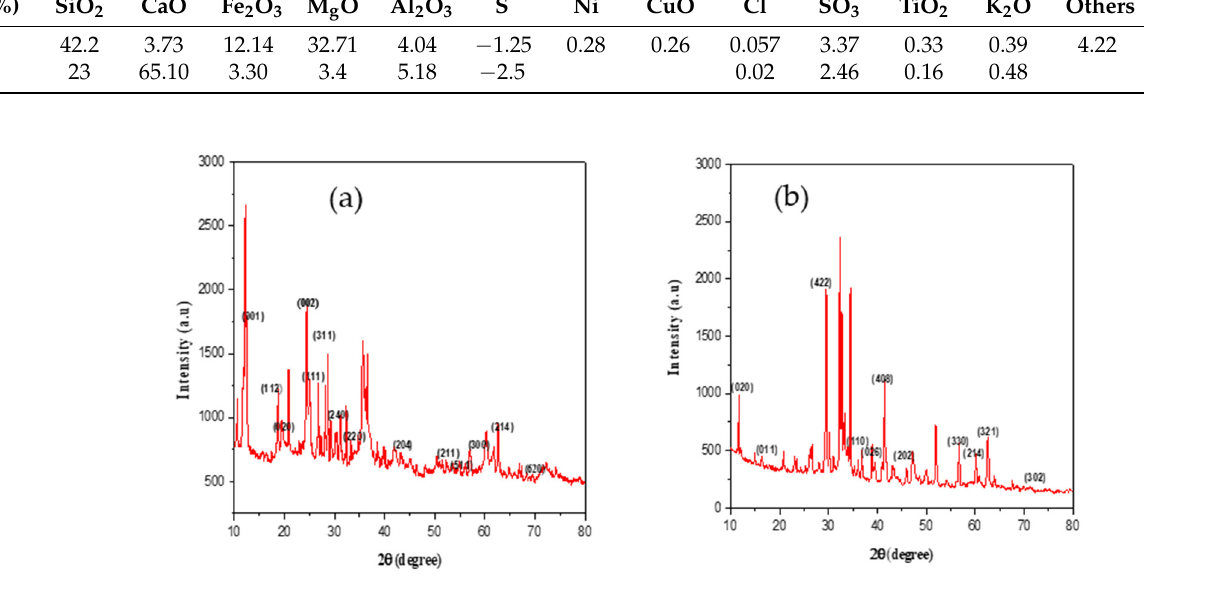
Table 2. Chemical characteristics of tailings and ordinary Portland